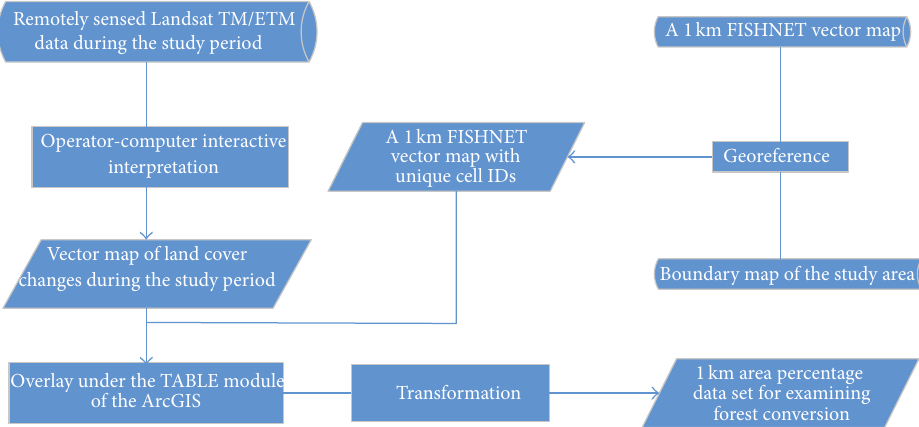
Figure 3: Flowchart of generating 1 km area percentage data set of land use